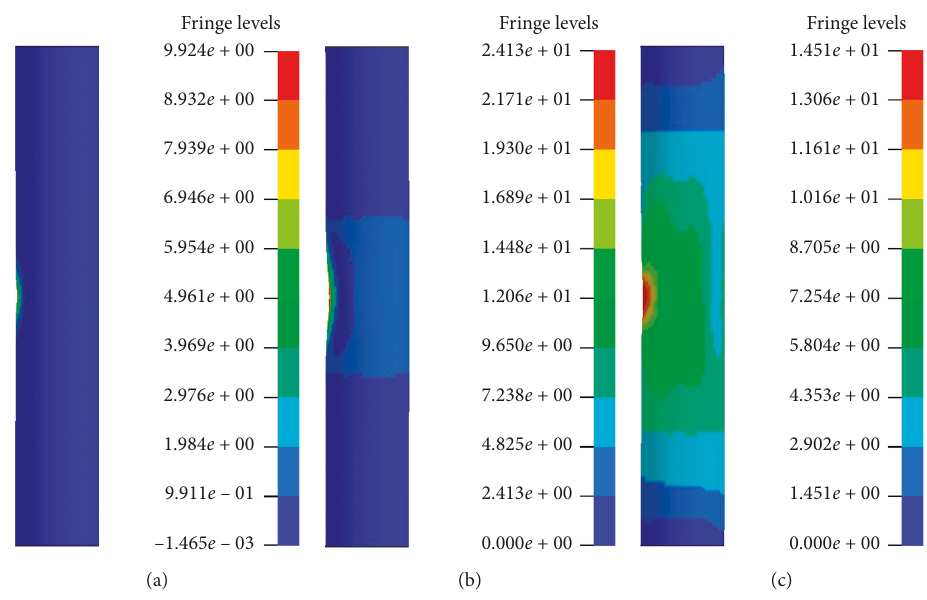
Figure 14: Contours of X -displacement at different time periods (left view): (a) t � 0.4ms, (b) t � 0.9ms, and (c) t �